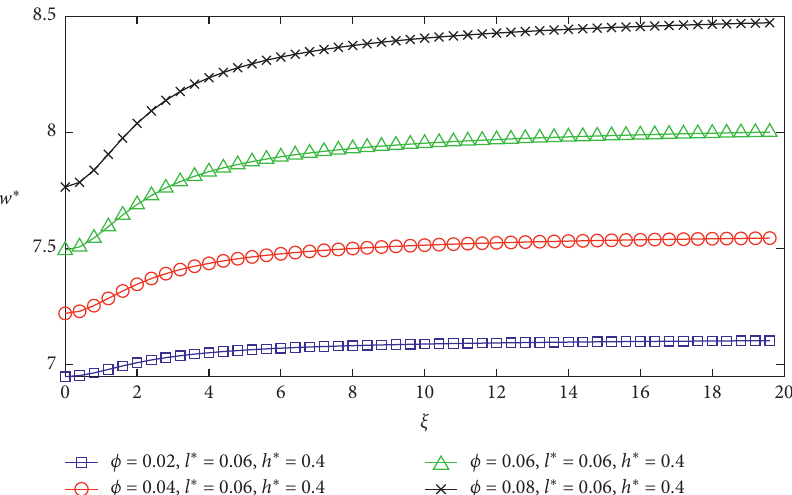
Figure 5: Variations of dimensionless load capacity versus Langevin parameter ξ for different values of Φ at l ∗ � 0.06 and h ∗ � 0.4.